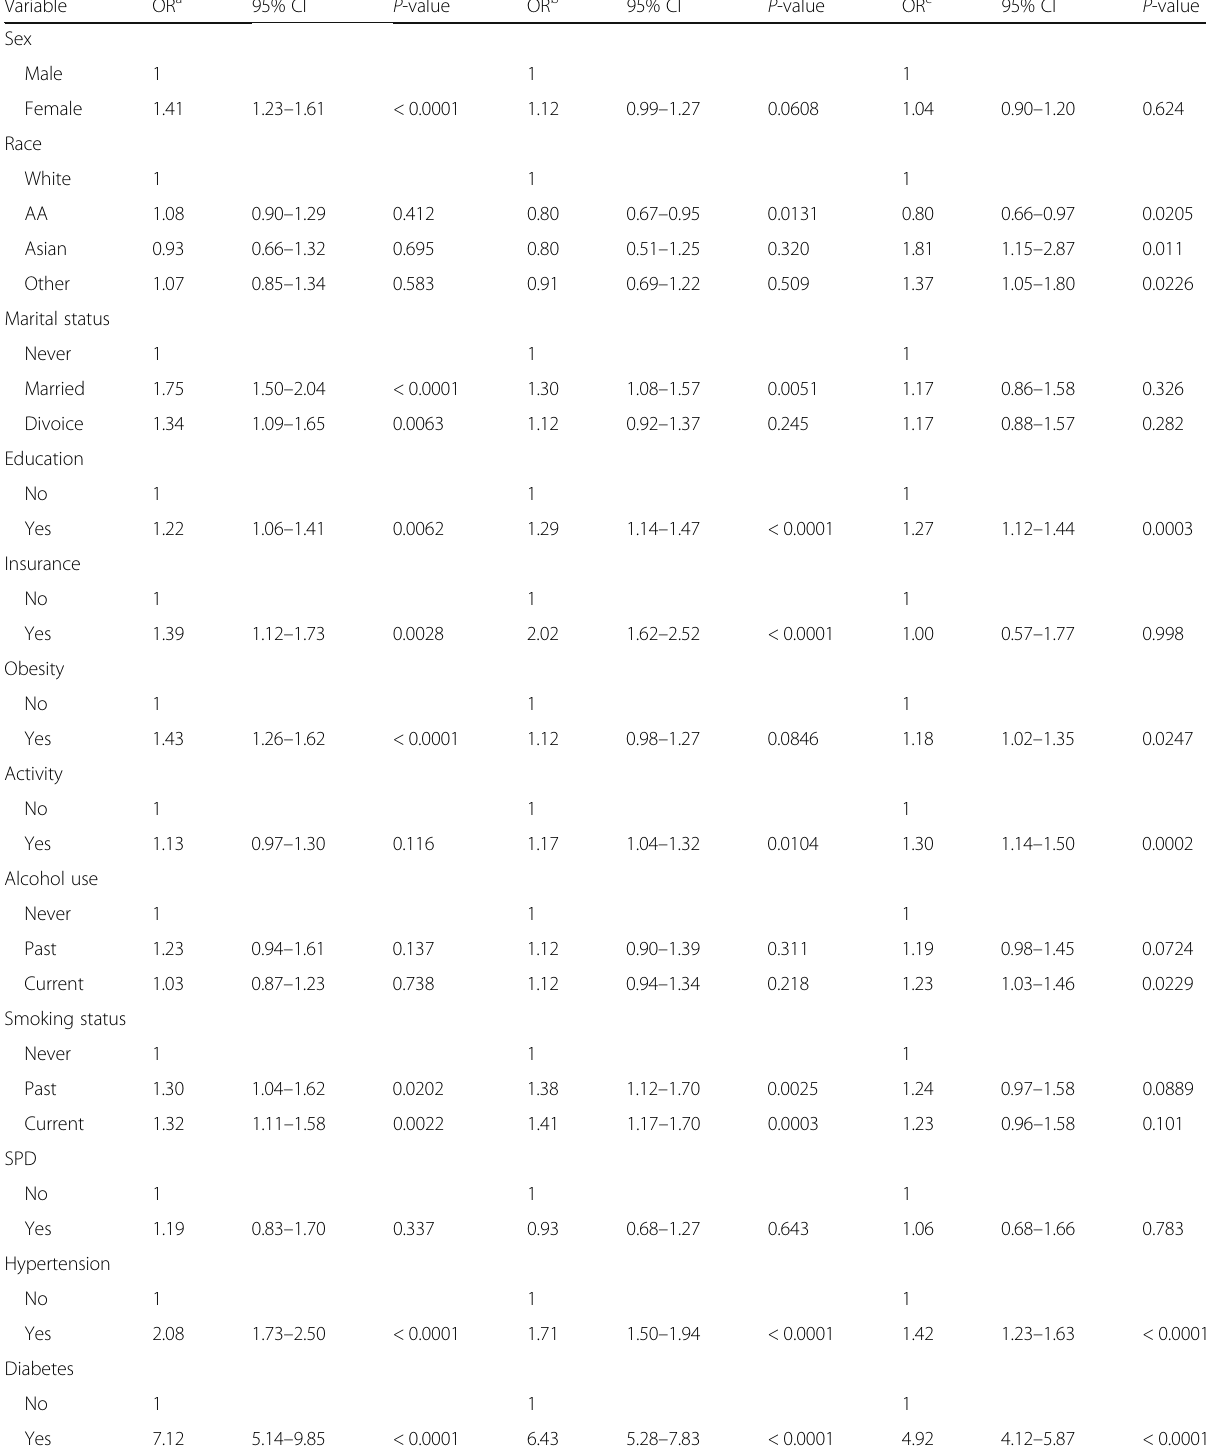
Table 4 Multiple logistic regression analysis for the relationship between potential factors and type 2 diabetes screening by age